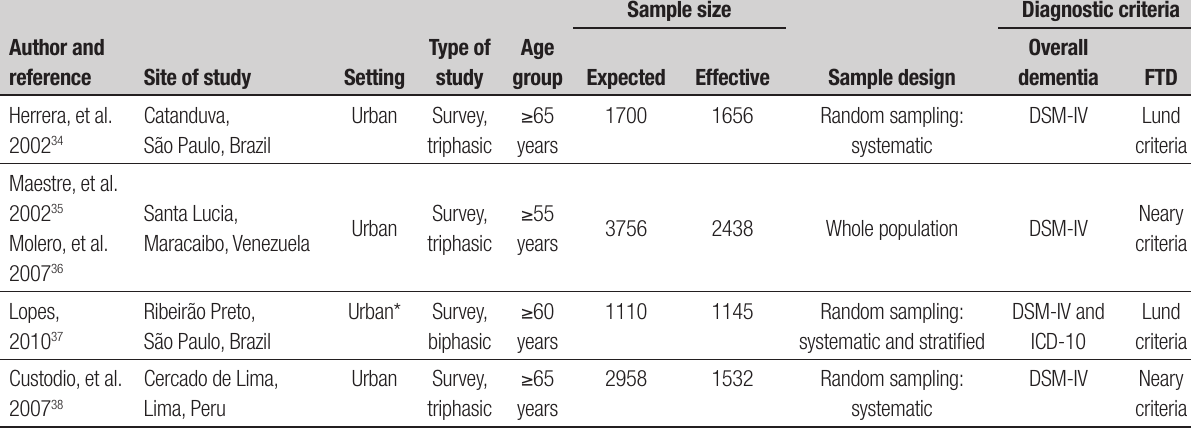
Table 1. Characteristics of the four population-based studies included in the present